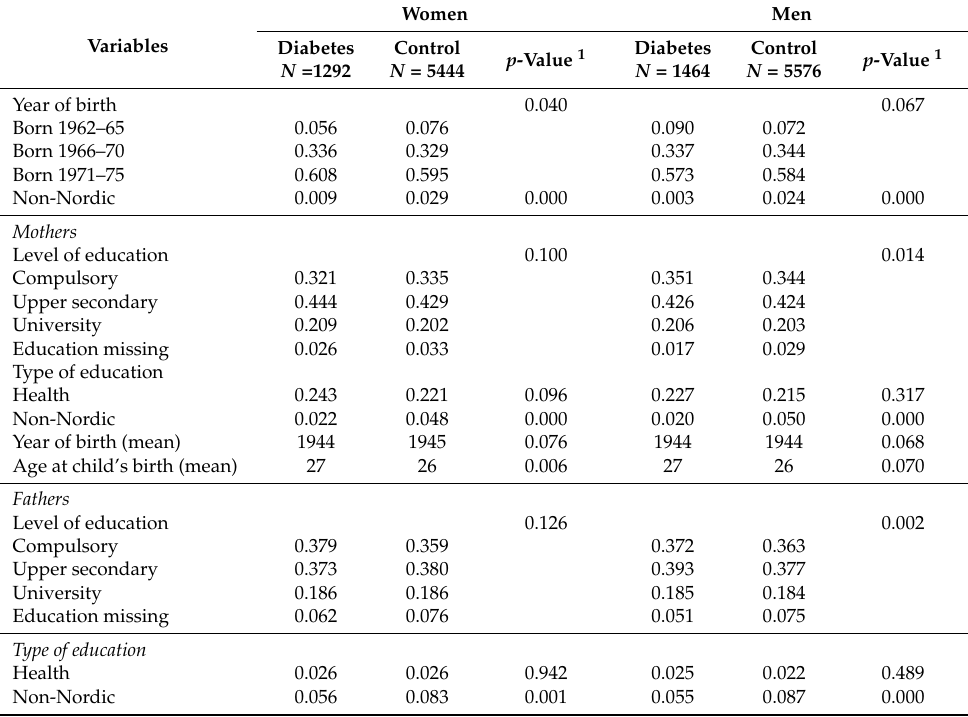
Table 2. Descriptive statistics of own and parents’ background factors. Numbers are proportions unless otherwise